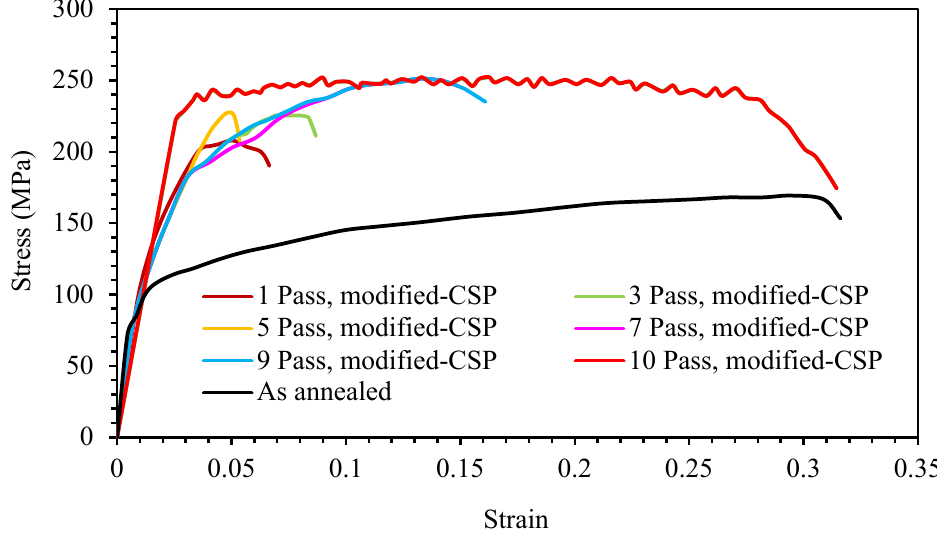
Figure 7. Stress-strain curves for as annealed, first, third, fifth, seventh, ninth, and tenth passes of the modified-CSP samples.